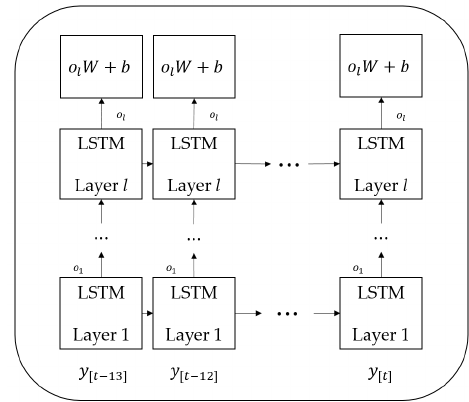
Figure 6. An LSTM network with l layers.